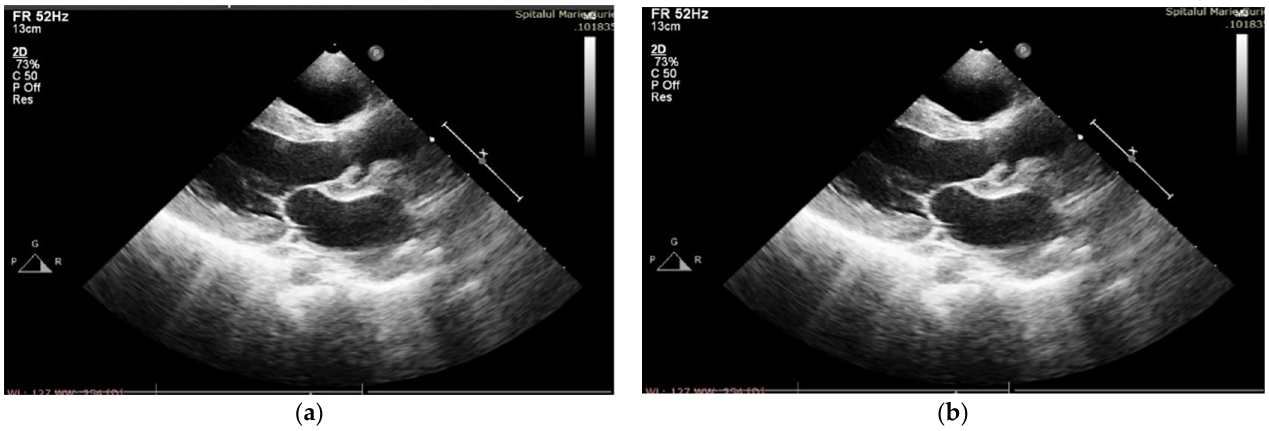
Figure 1. ( a ) TTE PLAX—paravalvular aortic abscess—in the course of formation; ( b ) after spontaneous evacuation.